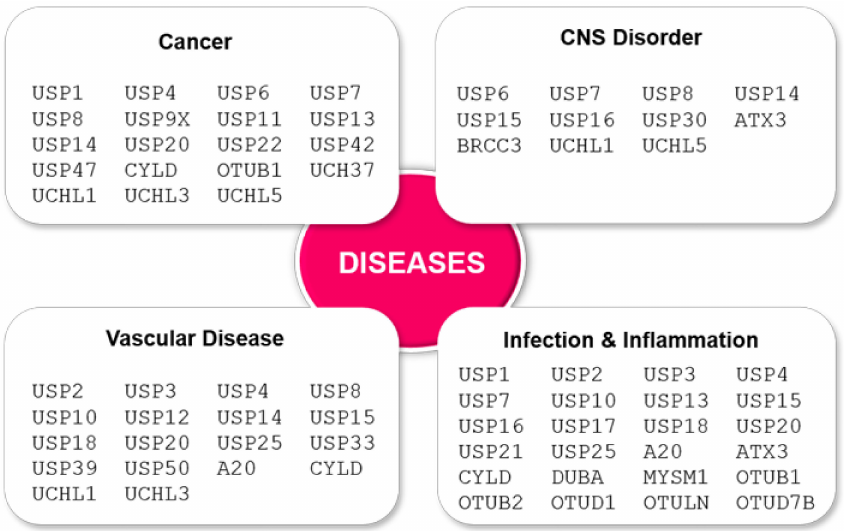
Figure 4. Disease-related